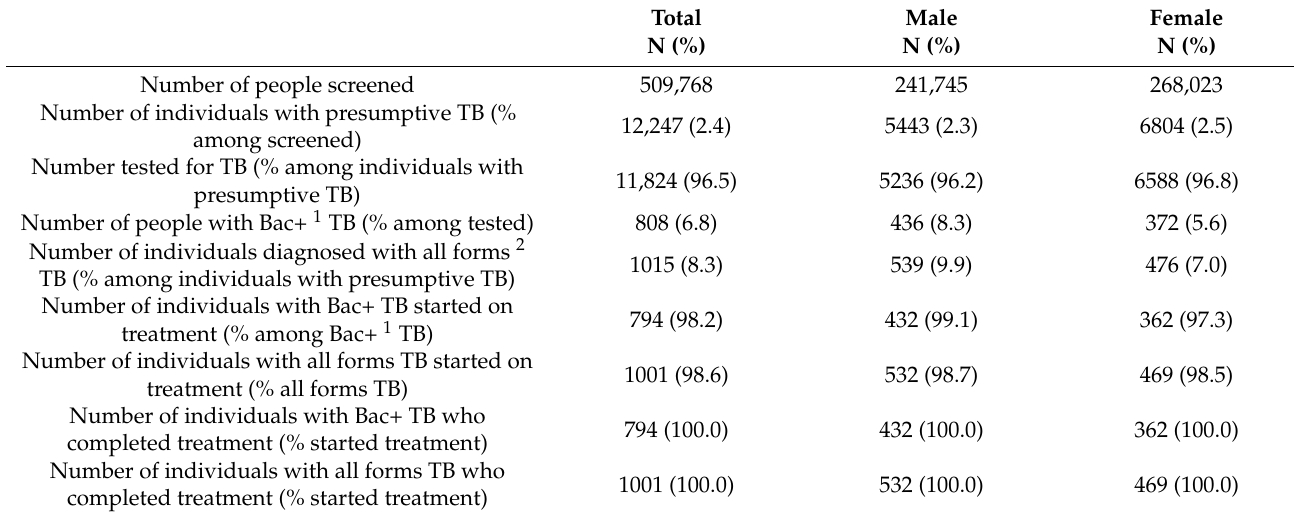
Table 1. Results of the intervention in lbeno, Oron, Mbo (Akwa Ibom) and in Biase, Obubra and Odukpani (Cross River).